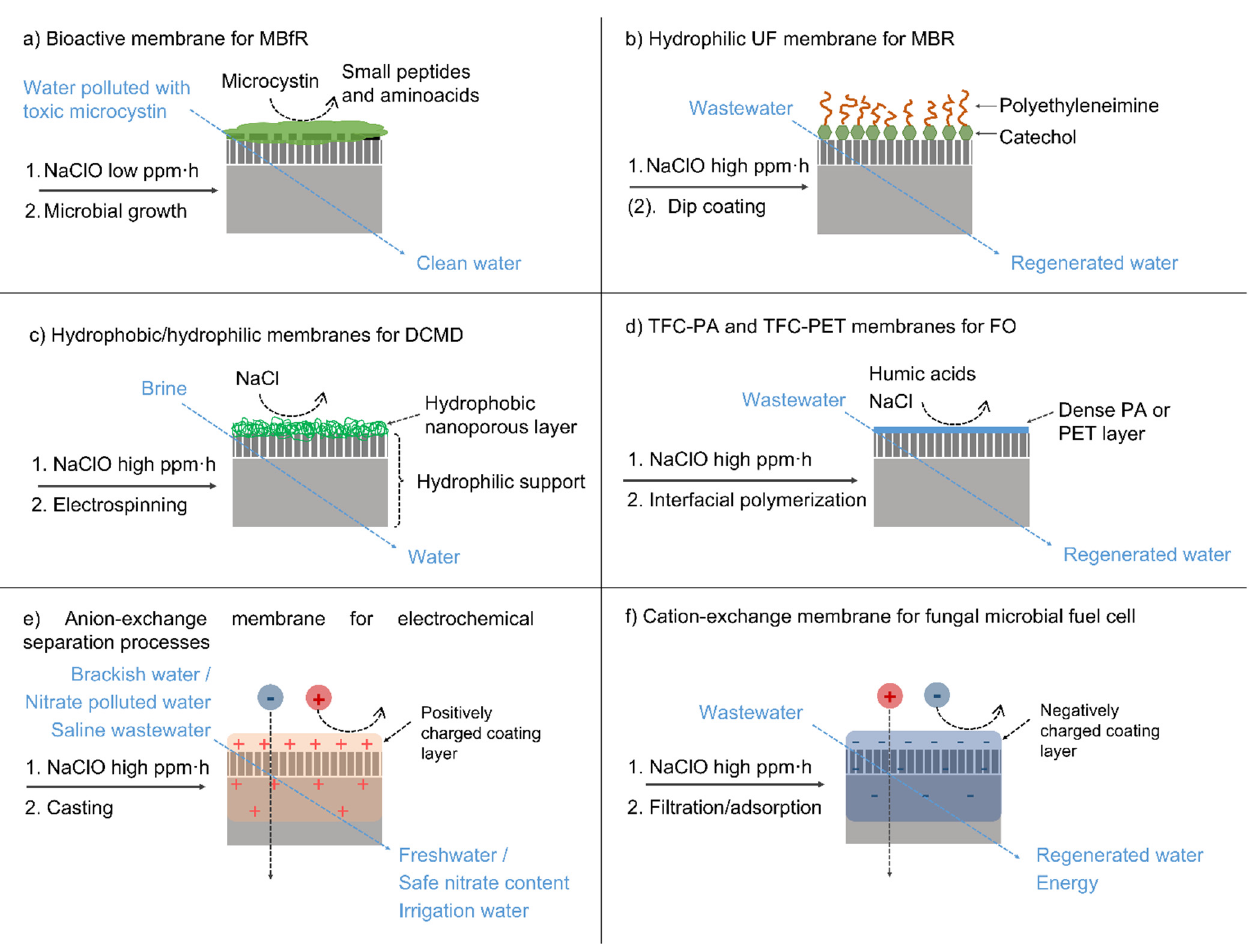
Figure 9. Schematic representation of innovative indirect EoL RO membrane recycling ap- proaches.